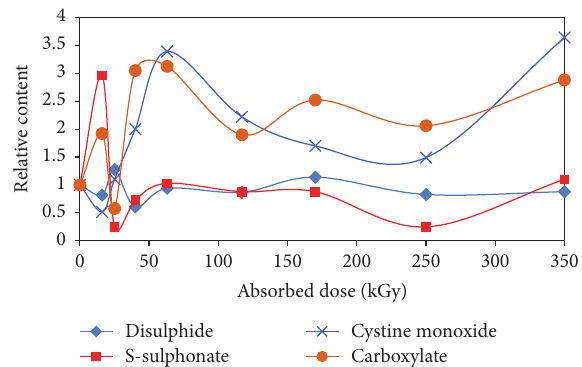
Figure 2: Development of relative content of disulphides, S-sul- fonate, cystine monoxide, and carboxylates 88 days after electron beam irradiation.